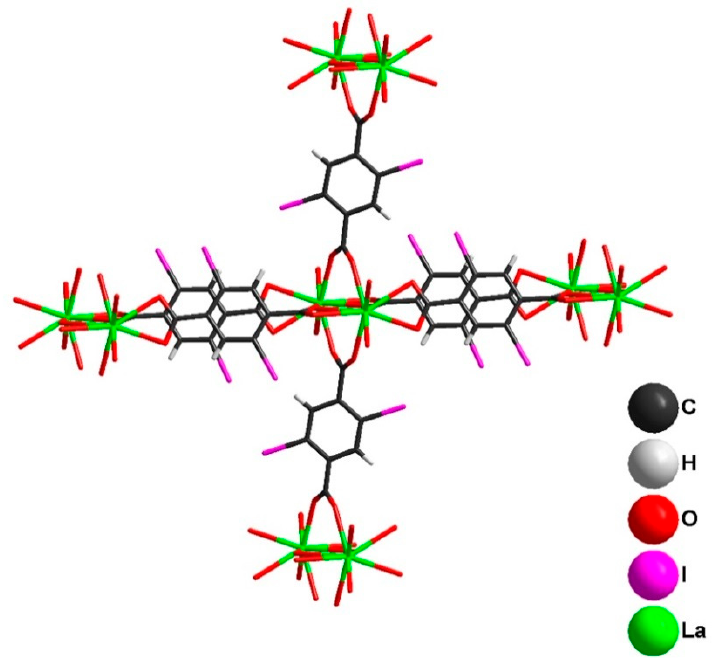
Figure 2. Connectivity between [La 2 (2,5-I-bdc) 6 (DMF) 4 ] units in the crystal structure of 1 . Disordered DMF molecules are omitted for clarity (only O-atoms shown).